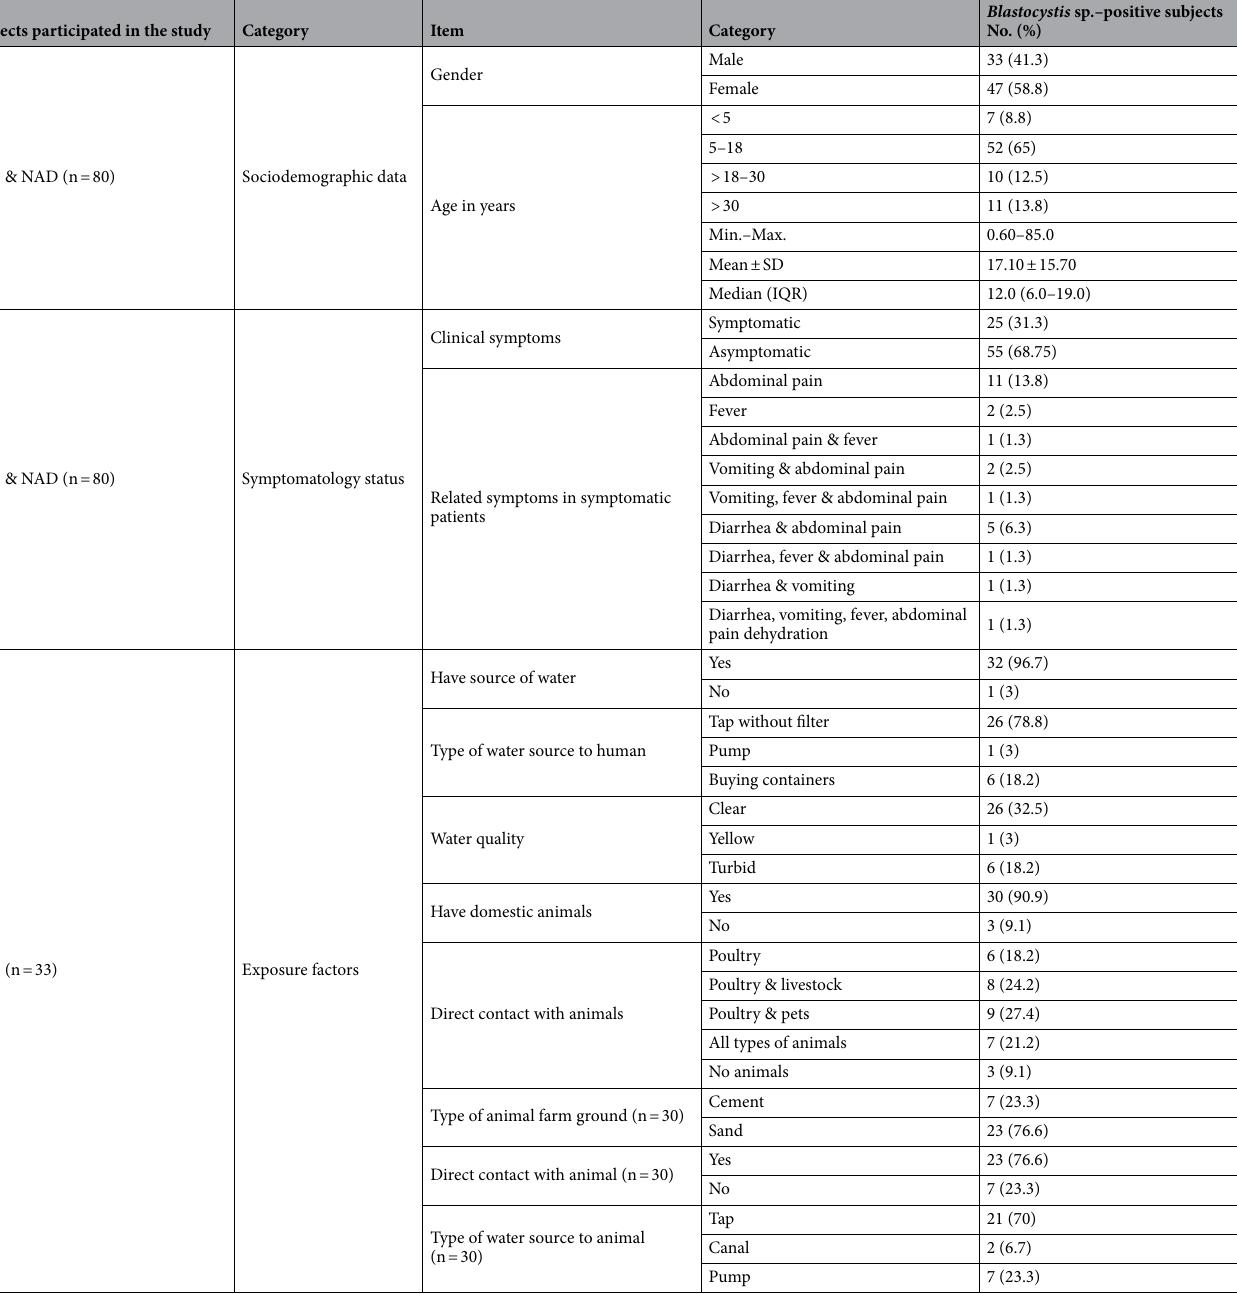
Table 1. Descriptive data concerning the sociodemographic and risk factors of Blastocystis- positive subjects in West Ismailia, Egypt. SAD: Subjects with available data, n = 33; NAD: Subjects with no available data, n = 47 (“These individuals were recruited through primary health care units during Ministry of Health and Population programs to eradicate schistosomiasis, [and] only gender, age, and symptoms were available”); IQR: Interquartile range; SD: Standard deviation; sp.: